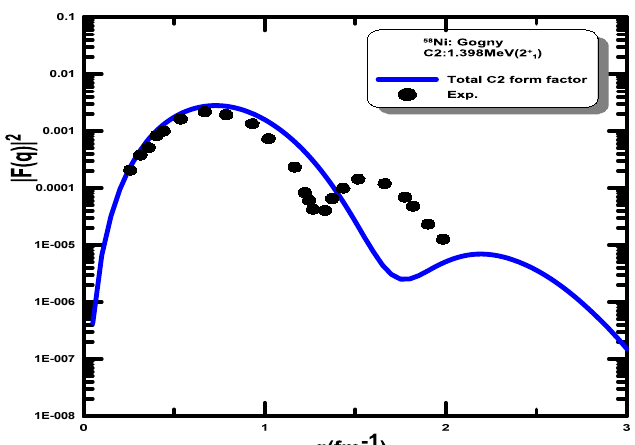
Fig.2: Inelastic longitudinal C2 form factors for the (E Gogny, theoretical data represented by solid curve, the experimental data (filled circle) are taken from Ref. [18].